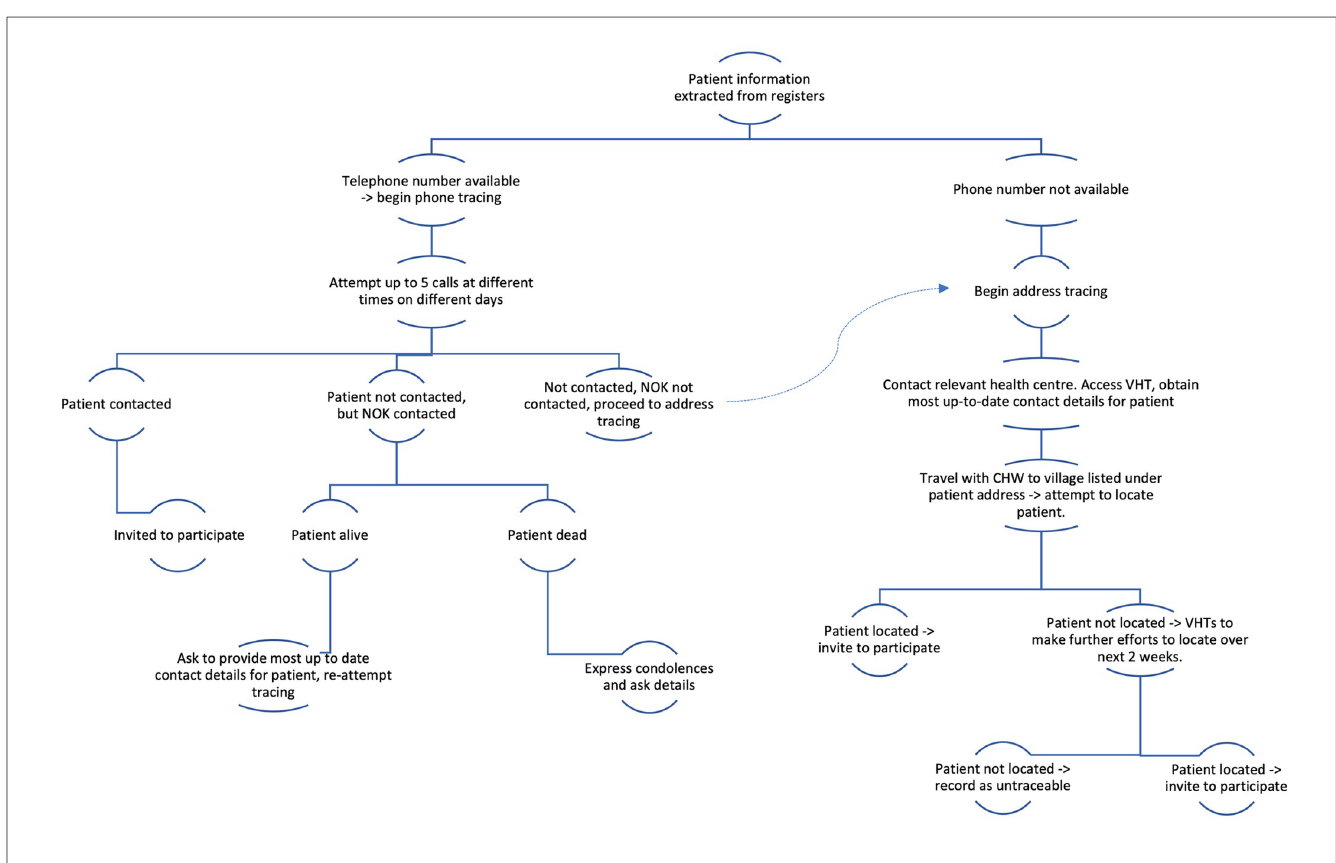
Fig 1. Participant tracing procedure. NOK = next of kin; VHT = village health